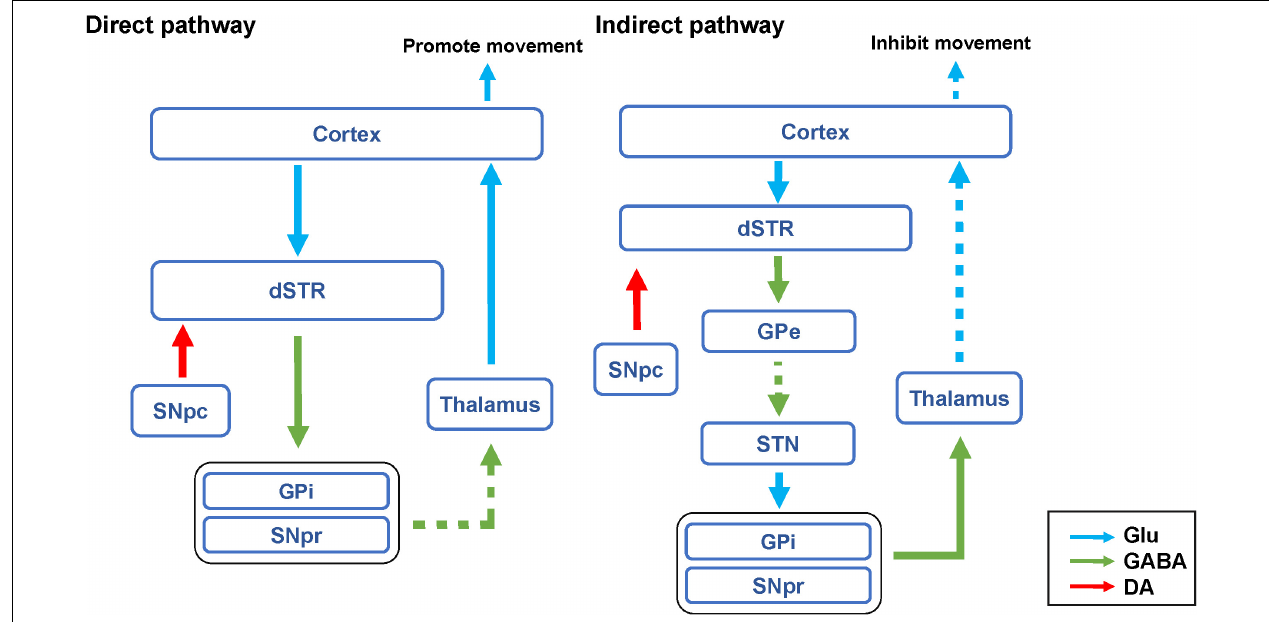
FIGURE 8 | Hypothesis diagram of direct and indirect pathways of basal ganglia motor regulatory system. The blue arrow represents glutamatergic (Glu) neuron transmission. The green arrow indicates GABAergic neuron transmission. The red arrow represents dopaminergic neuron transmission. The solid line represents activation. The dashed line indicates